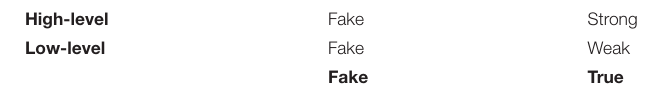
TABLE 1 | Depth and reality of personalization (Oinas-Kukkonen, 2018).